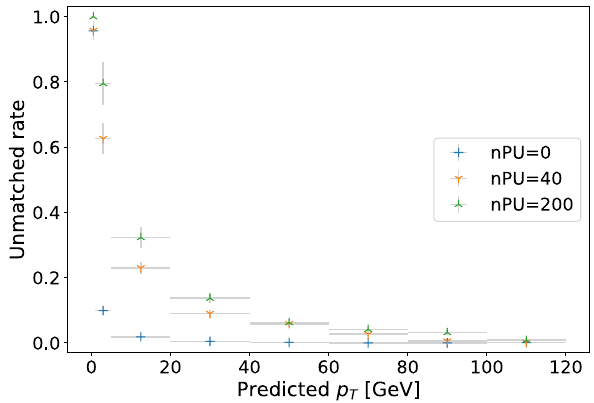
Fig. 12 Unmatched rate as a function of predicted p T